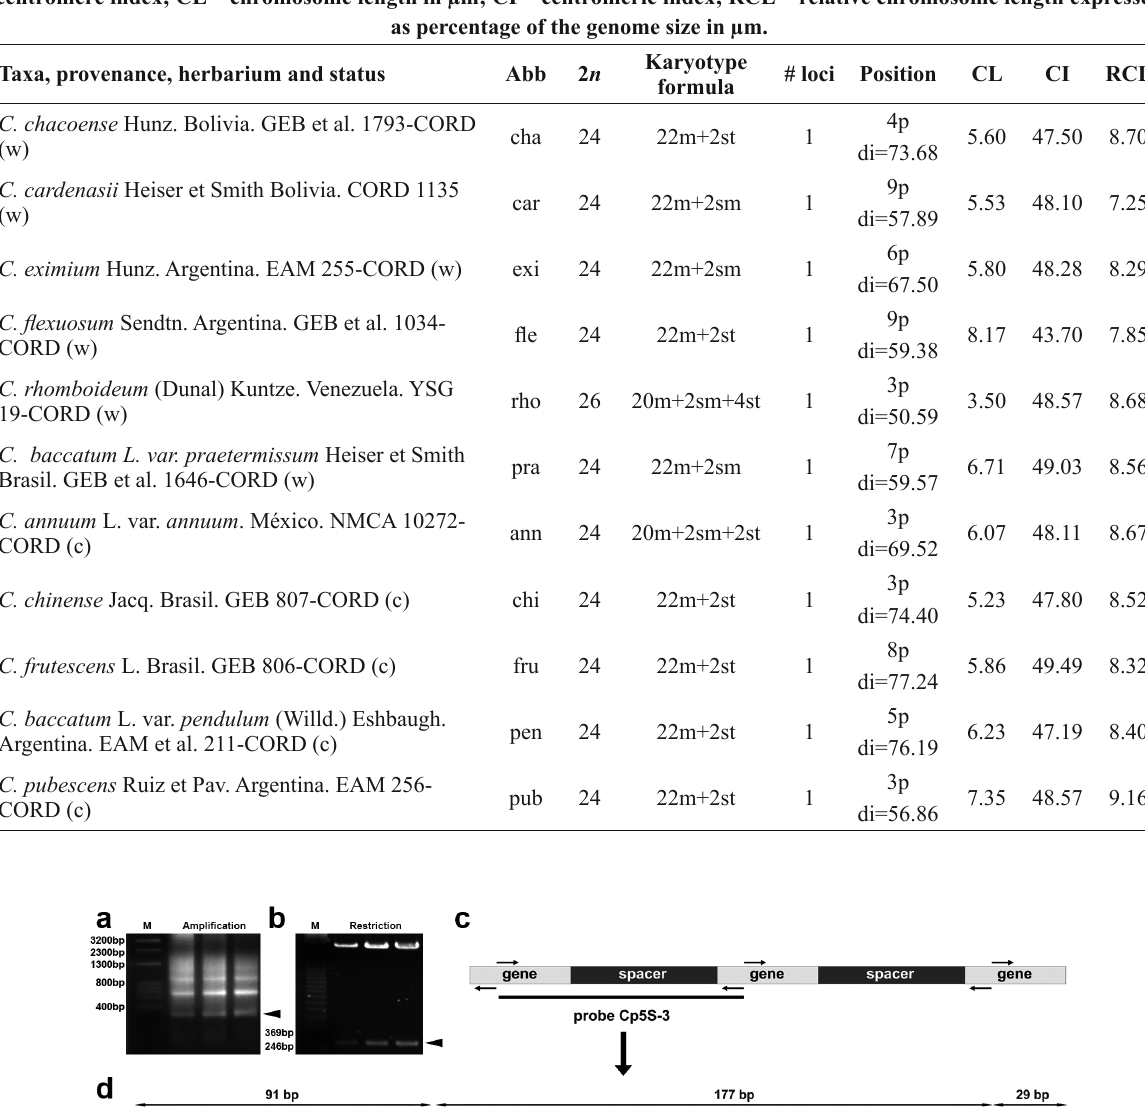
Summary of 5S rDNA FISH in Capsicum. CORD = Herbarium from Museo Botánico de Córdoba, Argentina; Status: c = cultivated; w = wild. Collectors: GEB = GE Barboza; YSG = Y Sánchez García; EAM = EA Moscone; Abb = Abbreviation; 2 n = somatic chromosome number; p = short chromosome arm; di = intercalary band distance to the